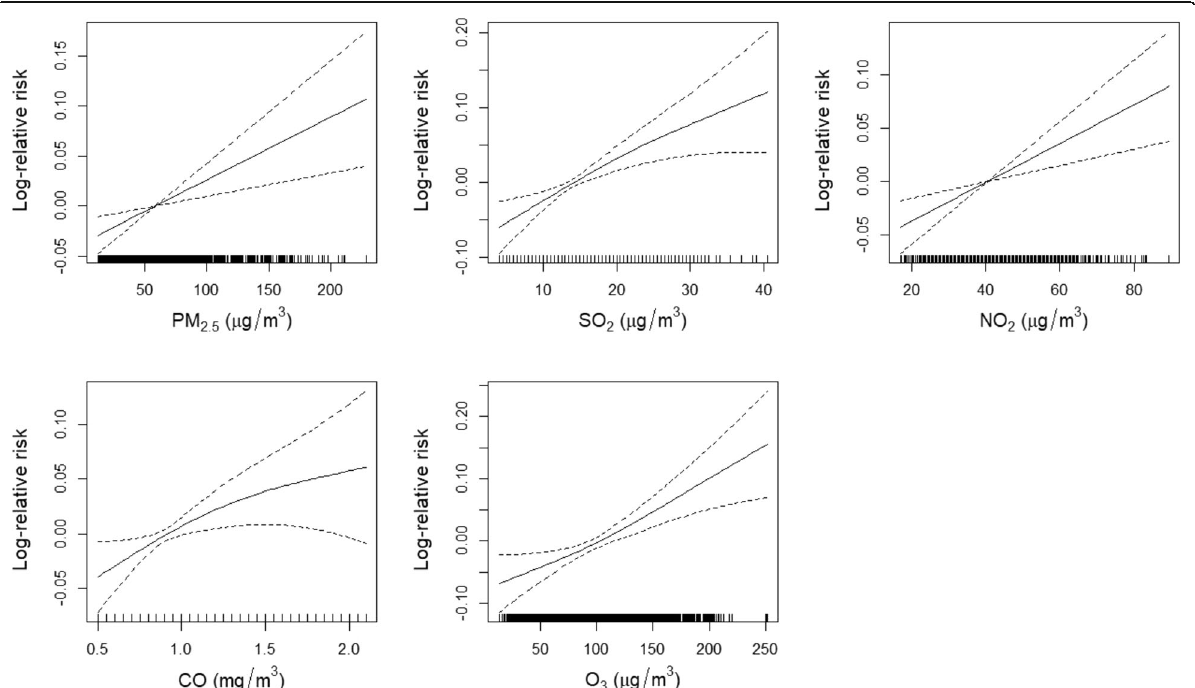
Fig. 3 Exposure-response curves for associations between concentration increases in each ambient airborne pollutant and COPD-related mortality. Curves for PM 2.5 , SO 2 , NO 2 , CO, and O 3 correspond to lag03, lag01, lag02, lag01, and lag02,